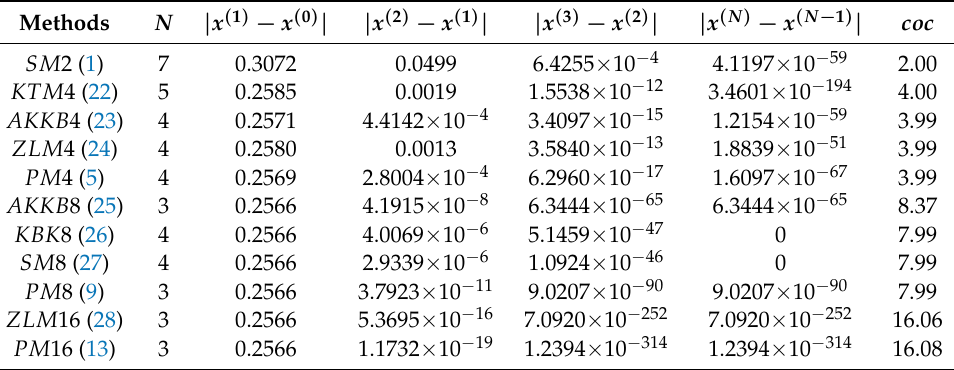
Table 5. Comparisons between different methods for f 5 ( x ) at x ( 0 ) = −